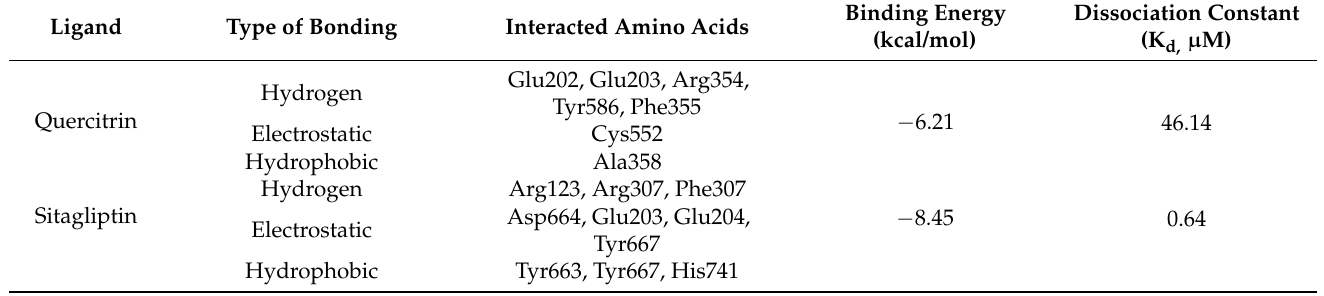
Table 4. The binding energy and dissociation constant of quercitrin and sitagliptin acting as ligands to interact with amino acids.